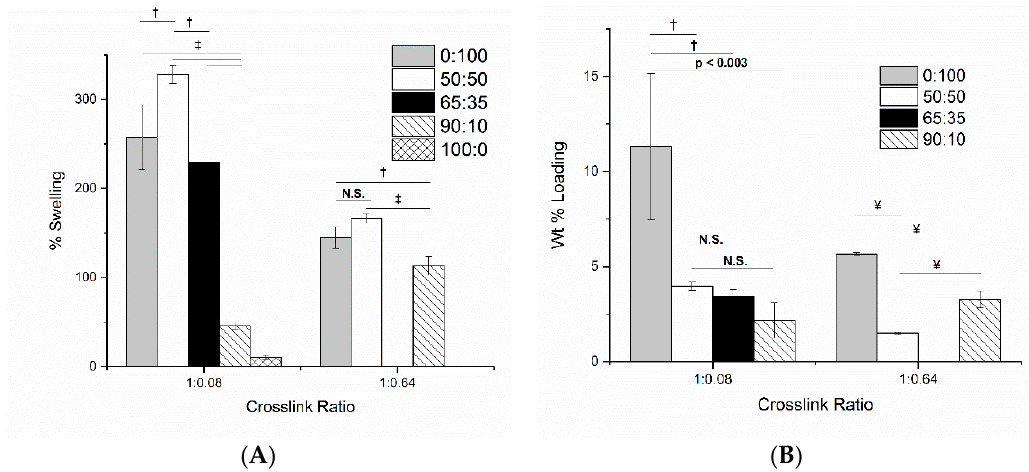
Figure 7. Solvent polarity has significant effects upon both pCD swelling ( A ) and minocycline (MNC) loading ( B ). pCD- β was chosen because it showed the least change in MNC loading and swelling across different crosslinking ratios. N.S. not significant ( p = 0.9); † p < 0.01; ‡ p < 0.001 ; ¥ p < 0.0001. Data shown is average ± std deviation for n = 3.